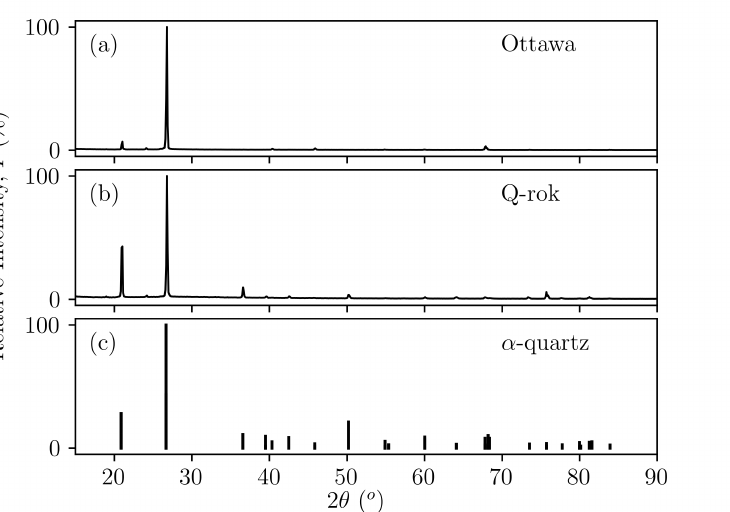
Figure 1. X-ray powder diffraction patterns: ( a ) Ottawa sand and ( b ) Q-Rok compared with diffrac- tion peaks of ( c ) α